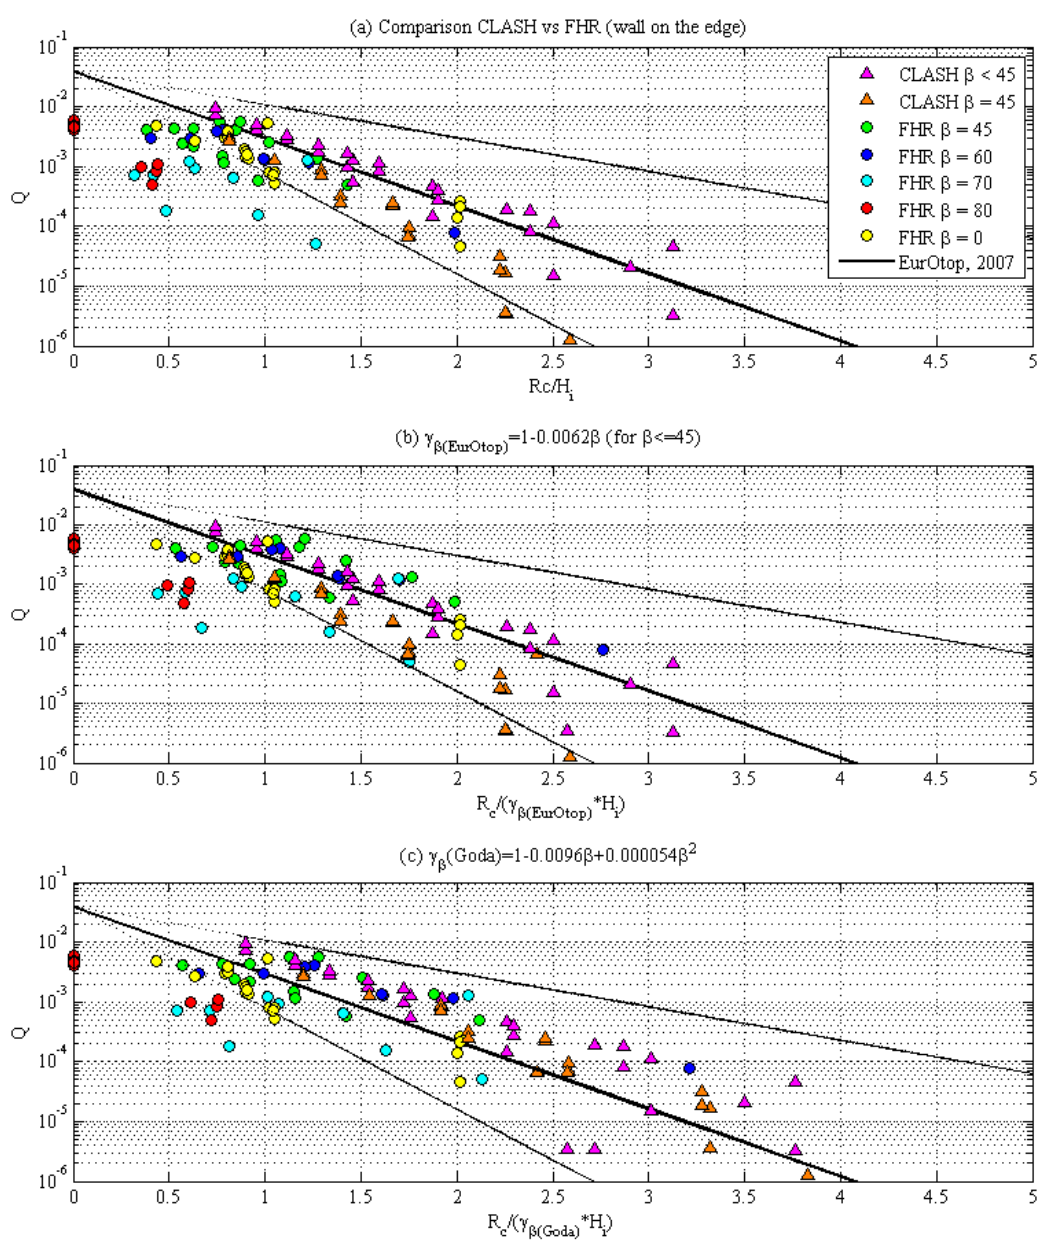
Figure11. CLASH and FHR(wall on the edge ofthe quay) data vs. EurOtop predictions: ( a ) overtopping Figure 11. CLASH and FHR (wall on the edge of the quay) data vs. EurOtop predictions: a) plotted against the non-dimensional freeboard; ( b ) overtopping plotted against the non-dimensional overtopping plotted against the non-dimensional freeboard; b) overtopping plotted against the non- freeboard, with the correction factor from EurOtop (2007) formula; ( c ) overtopping plotted against the dimensional freeboard, with the correction factor from EurOtop (2007) formula; c) overtopping non-dimensional freeboard, with the correction factor from Goda (2009) plotted against the non-dimensional freeboard, with the correction factor from Goda (2009) formula.